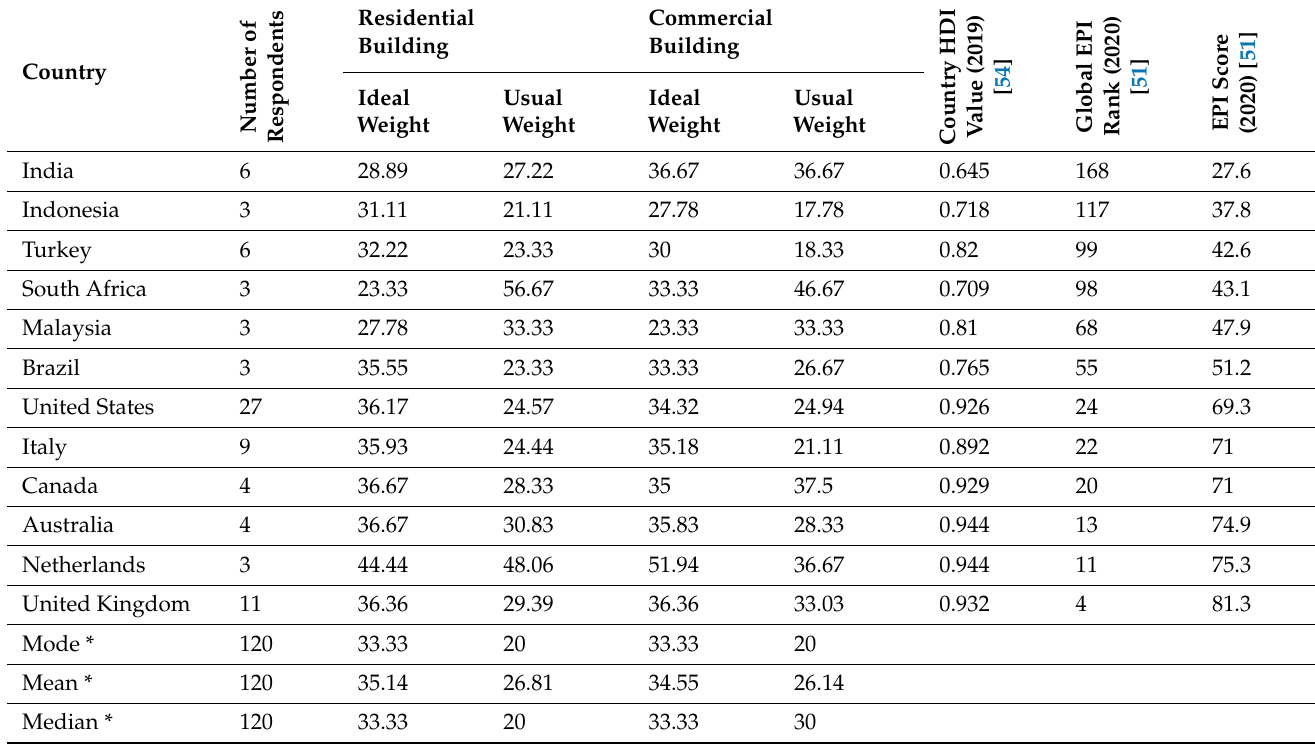
Table 3. Building environmental sustainability weights for different